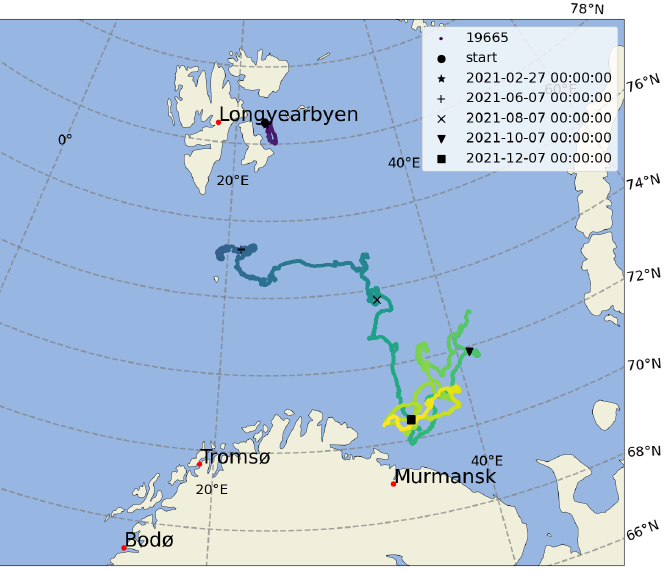
Figure 3. Overview of the drift trajectory of the early prototype instrument deployed in February 2021, East of Svalbard. The interruption in the trajectory is due to a layer of snow covering the instrument that prevented satellite communications during a couple of months. The instrument then drifted freely in the open ocean. This validates the low-power design and confirms that the chosen design is able to sustain operations for several months using just a few D-cell Lithium